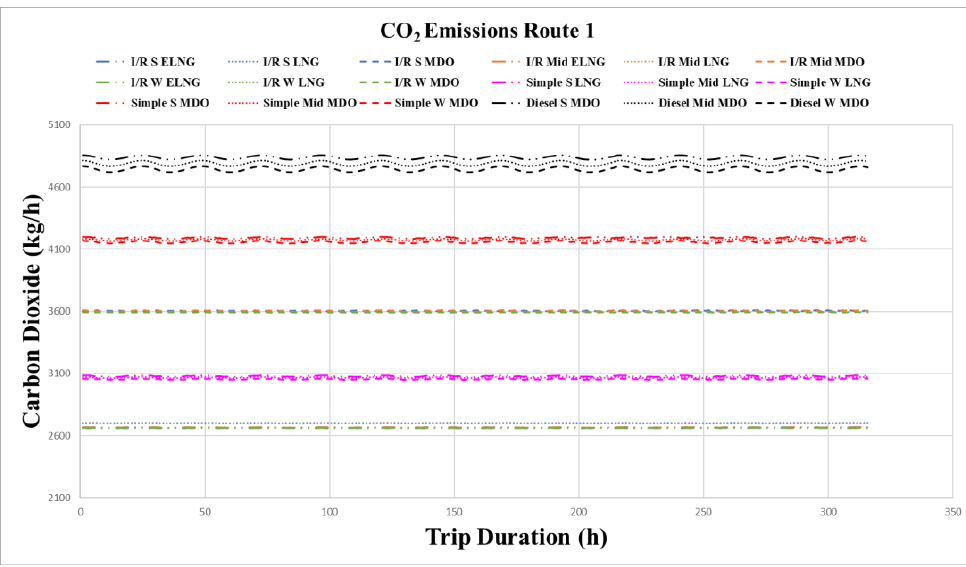
Figure 10. CO 2 emissions of various propulsion systems of the large container ship travelling between Shanghai and Los Angeles. I/R: intercooler/reheater CCGT; R: reheater CCGT; S simple CCGT; Diesel: two-stroke diesel engine; W: winter; Mid: midseason; S: summer.